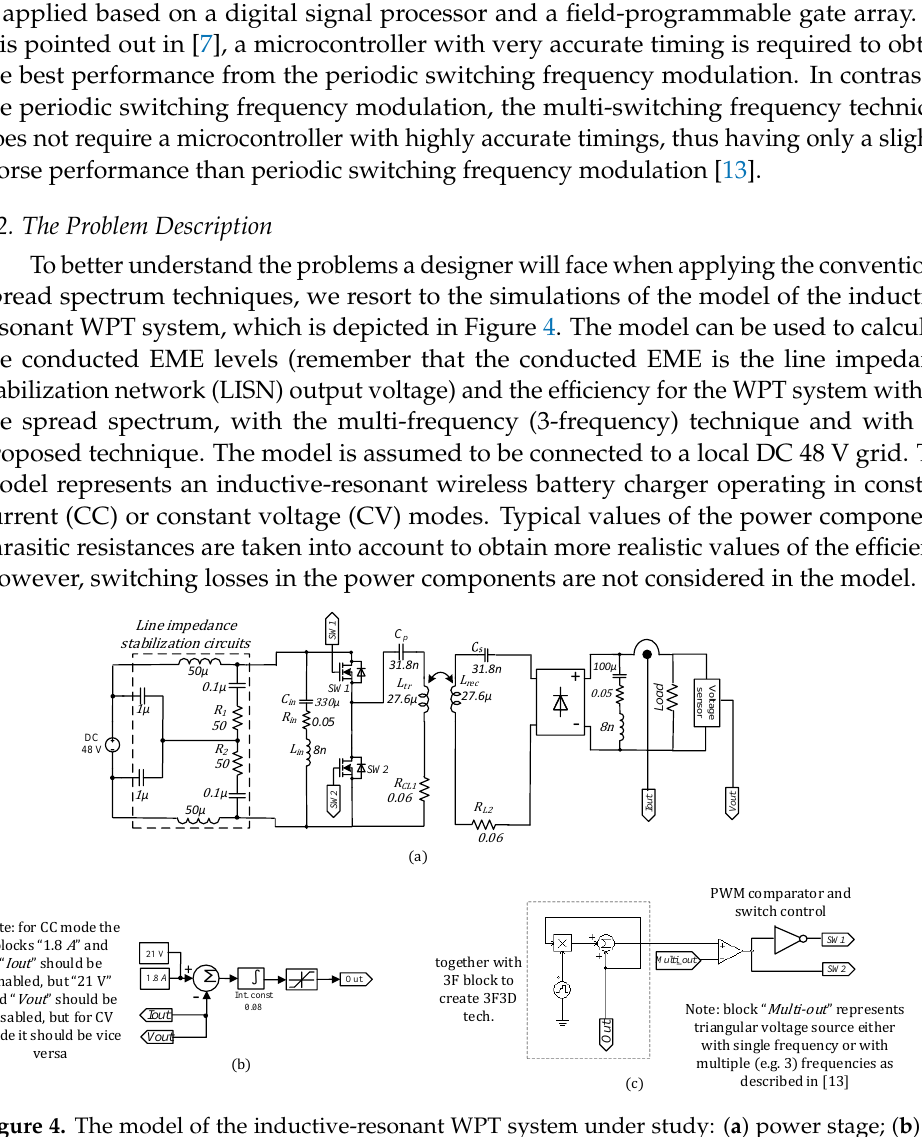
Figure 4. The model of the inductive-resonant WPT system under study: ( a ) power stage; ( b ) CC CV control; ( c ) PWM comparator and a block to create different duty cycles. Note: in CC mode output current is 1.8 A, but in CV mode output voltage is 21 V. The wireless charger can be used to charge 5-cell Li-ion batteries. Also note: the staircase voltage generator in should be zeroed if 3F3D technique is not used.